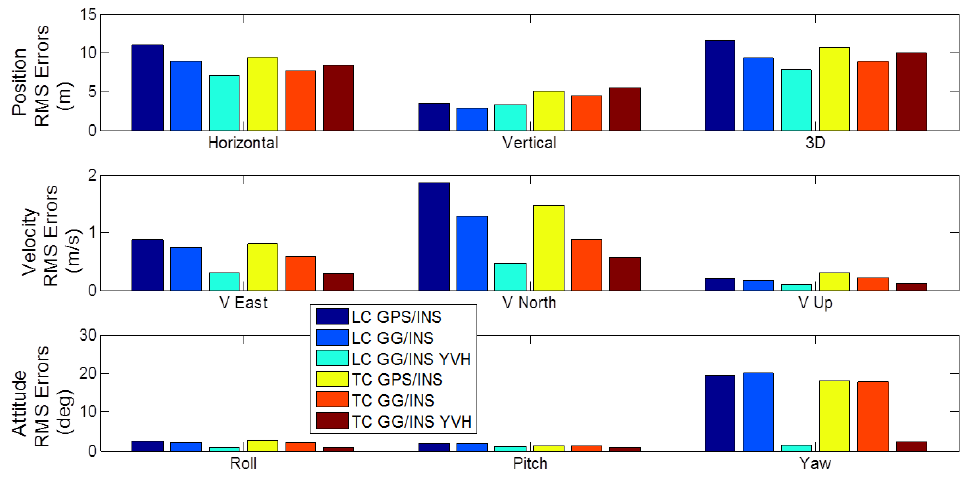
Figure 18. Comparison between LC and TC architectures in terms of position, velocity and attitude RMS errors (Segment 3).